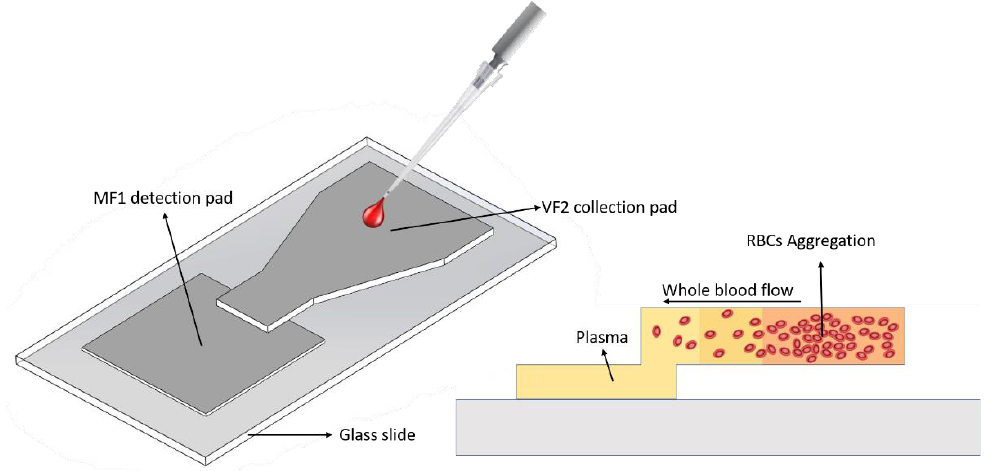
Figure 1. Schematic representation of the paper-based BPS device. The whole blood sample is add-ed to the VF2 collection pad, which performs vertical and lateral plasma separation. The addition of NaCl to the VF2 pad induces RBCs aggregation and higher plasma wicking as cells crenate and become stuck in the VF2 matrix due to hypertonic conditions.